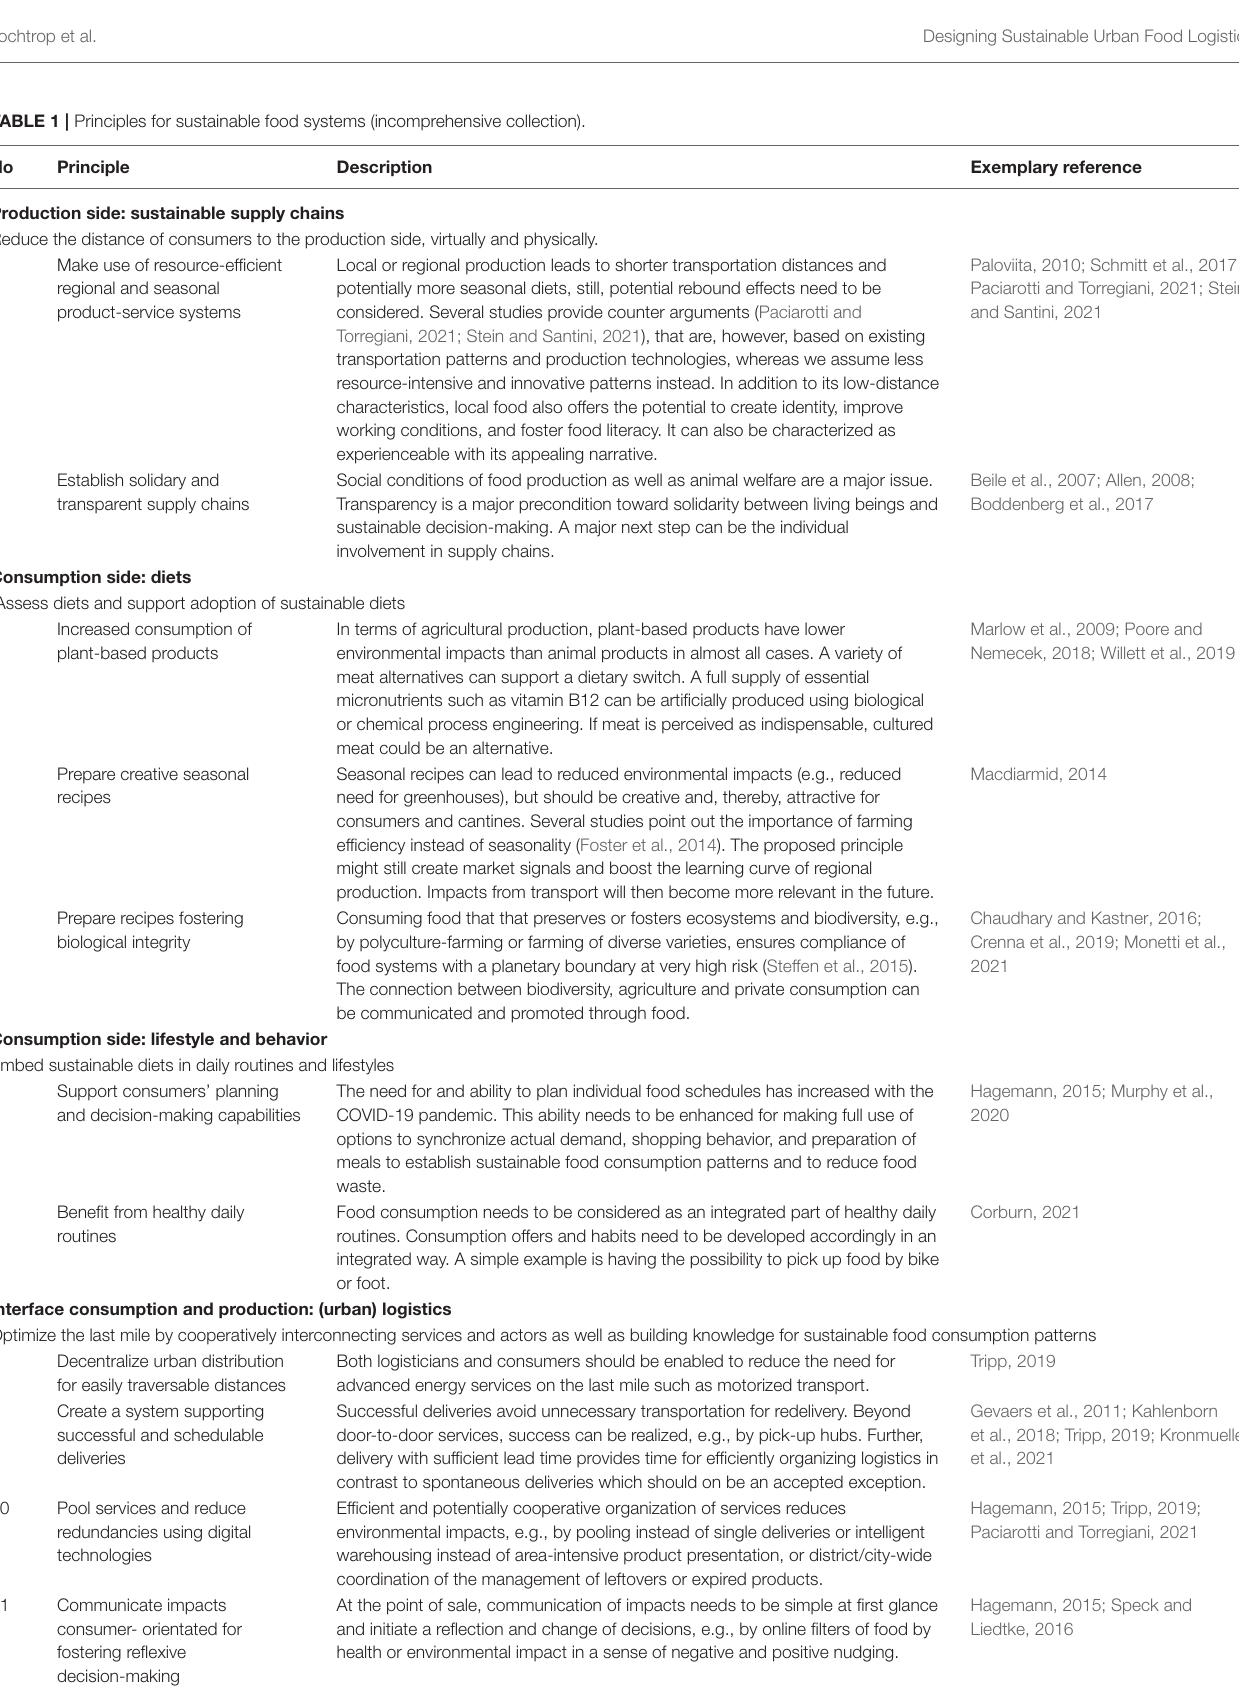
TABLE 1 | Principles for sustainable food systems (incomprehensive